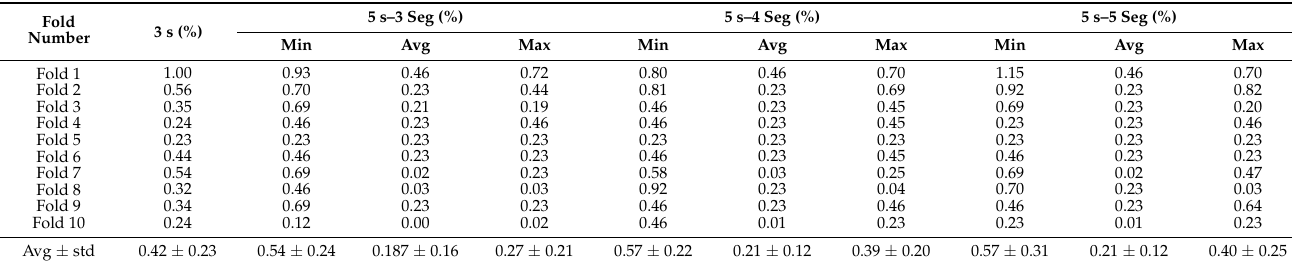
Table 11. Authentication System 5 s–3 seg